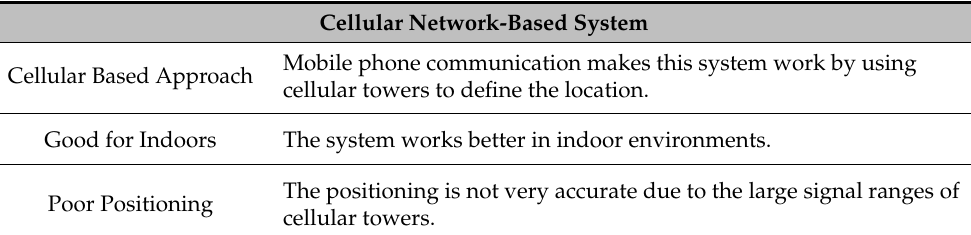
Table 10. Properties of Cellular Network-Based Navigation Tools.